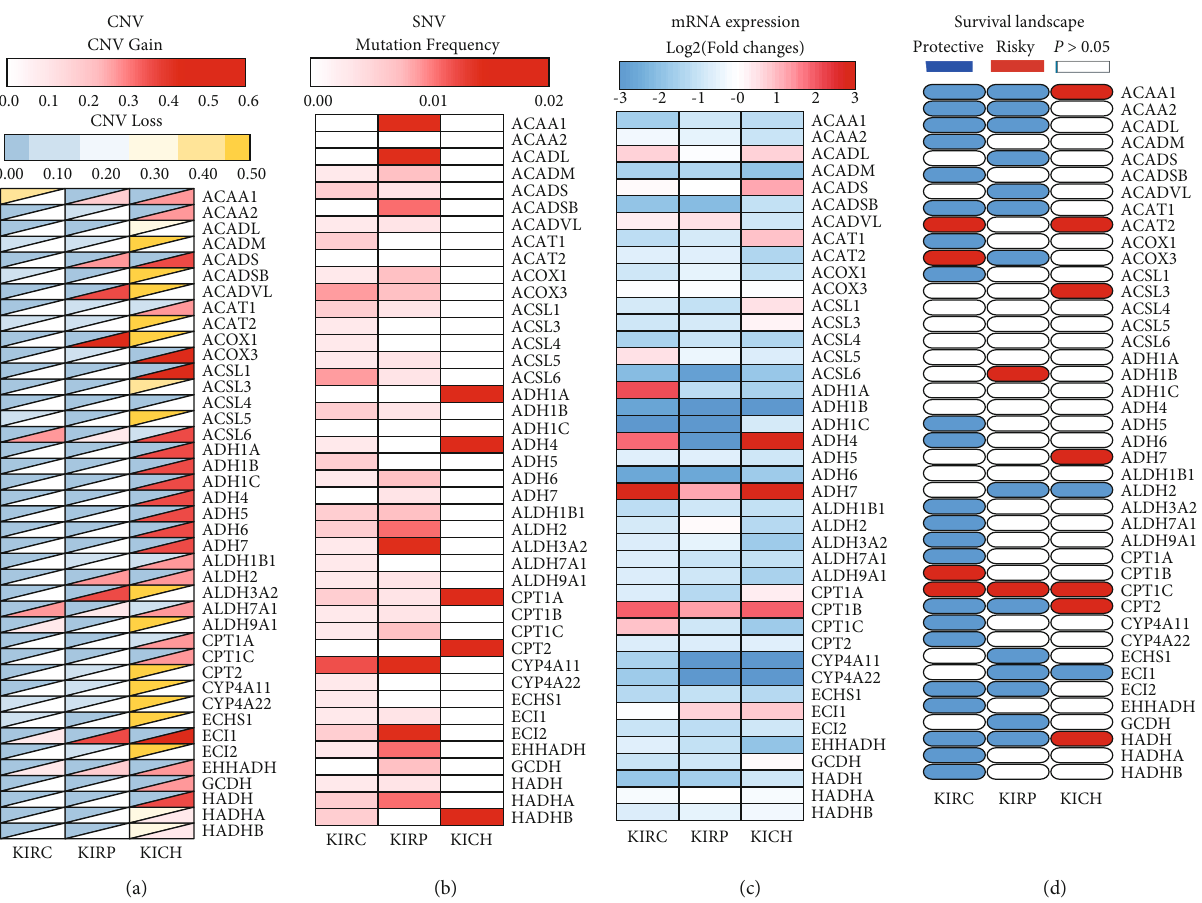
Figure 3: Overview of fatty acid metabolism genes in pan-renal cell carcinoma. (a) CNV in pan-renal cell carcinoma. The lower half of the rectangle represents the CNV gain. The redder the color, the higher the frequency of variation. The upper part represents the CNV loss. The yellower the color, the higher the frequency of variation. (b) SNV in pan-renal cell carcinoma. The redder the color, the higher the frequency of variation. (c) The mRNA expression of fatty acid metabolism genes in pan-renal cell carcinoma. Red indicates that the corresponding gene is upregulated in the tumor tissue. Blue indicates that the corresponding gene is downregulated in the tumor tissue. (d) The survival landscape of fatty acid metabolism genes in pan-renal cell carcinoma. Blue represents protective factors, red represents risk factors, and white represents a P value > 0.05, which is not statistically signi fi